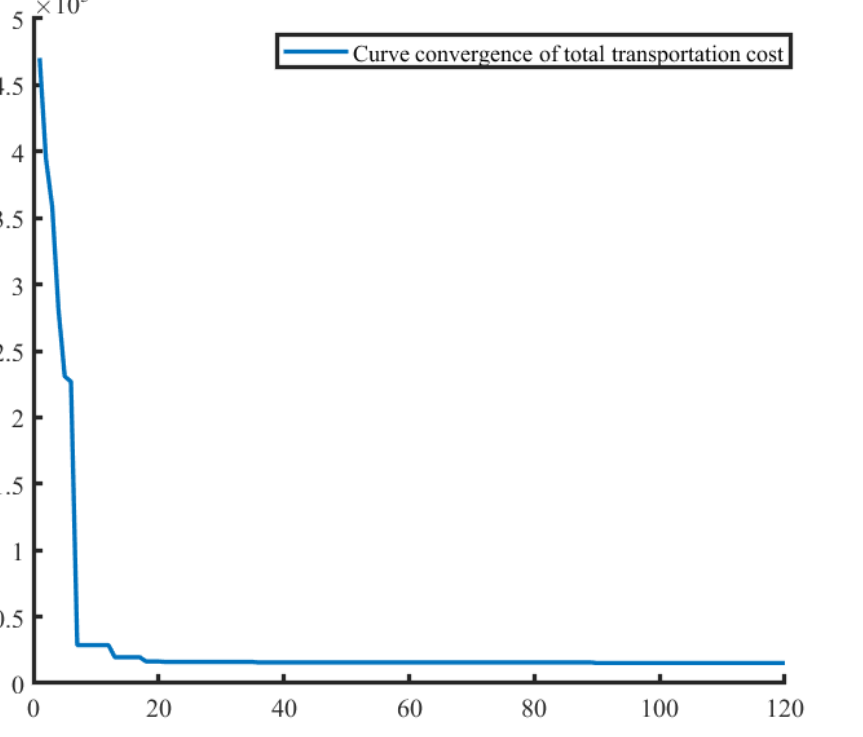
Figure 5. The variation of the minimum cost value.